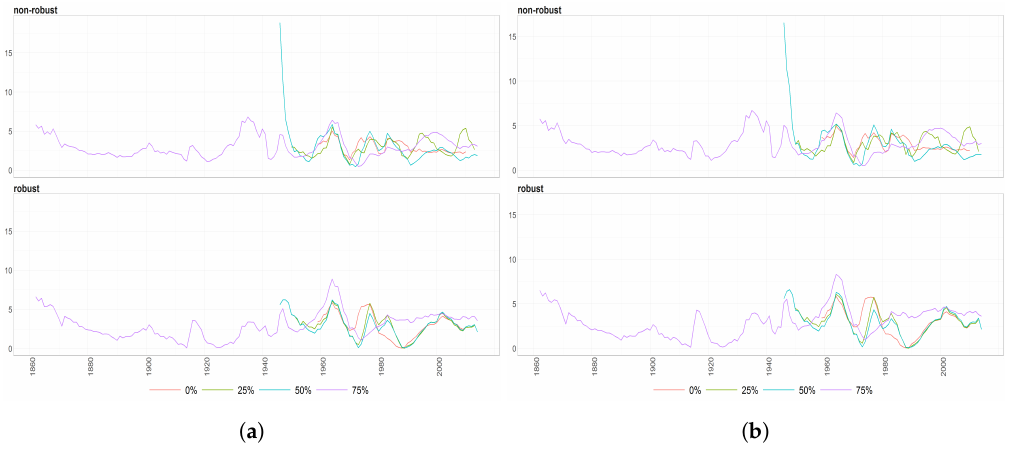
Figure 7. The Mahalanobias distances obtained using Probabilistic Principal Component Analysis (PPCA) for Females ( a ) and Males ( b ) Births over time (x axis). Different colours of lines correspond to the cases of different percentages of maximal missing values in a signle observation (light blue (75%), dark brown (50%), dark blue (25%), light brown (0%)). Every subfigure is divided into two subplots corresponding to robust estimation of standard divinations (upper plot) and sample one (bottom